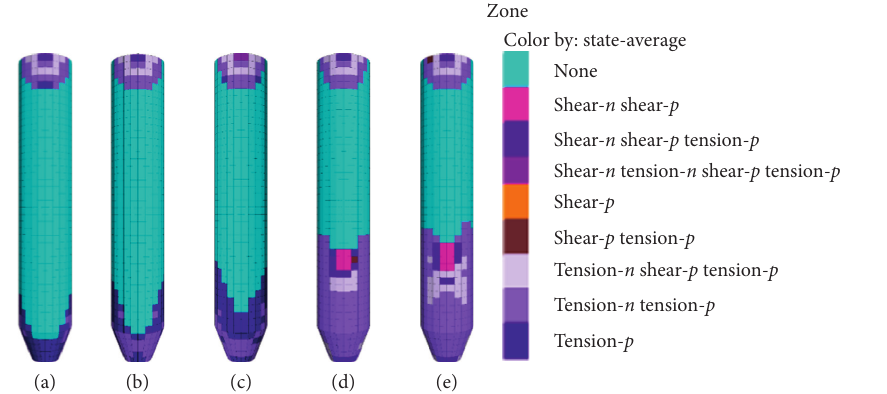
Figure 9: Distribution of plastic zone on the silo wall. (a) λ � 0.6. (b) λ � 0.8. (c) λ � 1.0. (d) λ � 1.2. (e) λ �